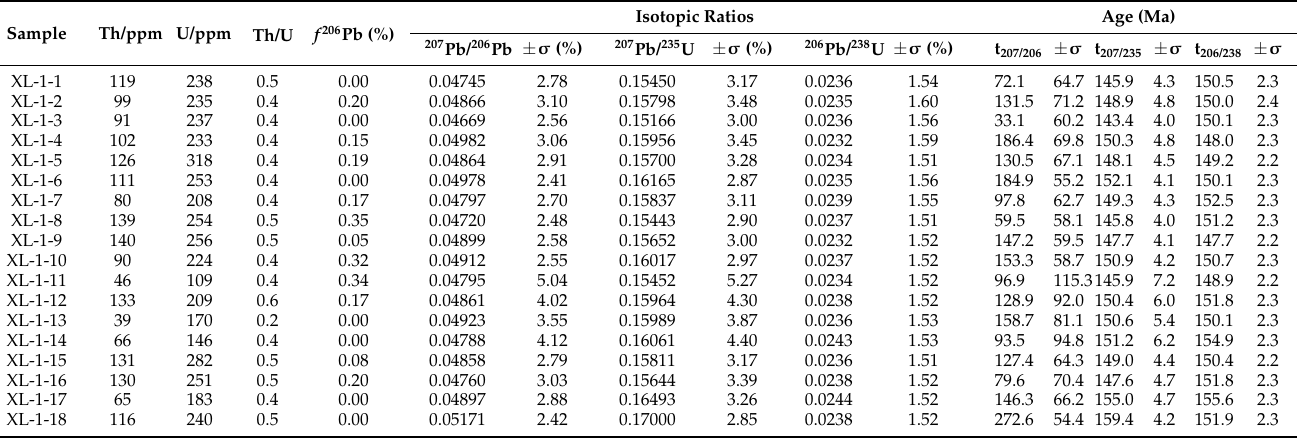
Figure 6. Re–Os isochron diagram ( a ) and mean age diagram ( b ) for molybdenite samples from the Xianlin Mo(Cu)-Fe deposit.